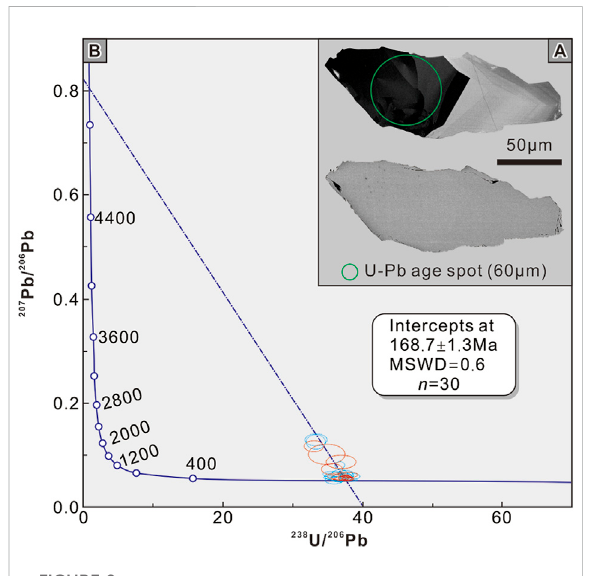
FIGURE 9 (A) Representative CL and BSE images of cassiterite crystals and (B) U – Pb Concordia plot for cassiterite from the Baimianshan segment, Xinlu Sn-Zn deposit. The red and blue plots are the data from the rim and core of cassiterite,